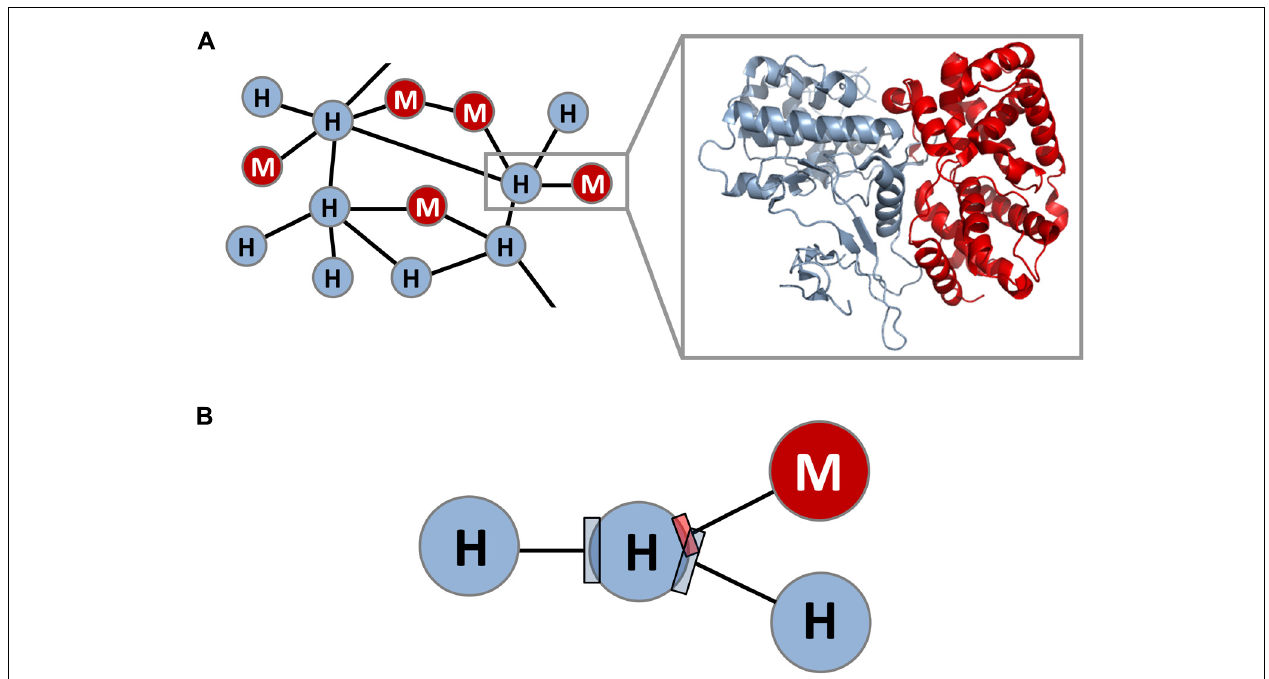
(between-species interactions). (B) The resulting host–microbe structural interaction network reveals high-resolution geometrical relationships between exogenous interfaces (between-species interfaces) and endogenous interfaces (within-species interfaces) that are otherwise hidden in the binary PPI network. In this example, a microbial protein is seen to bind to a target protein in the host at the same site as another host protein, albeit using a smaller